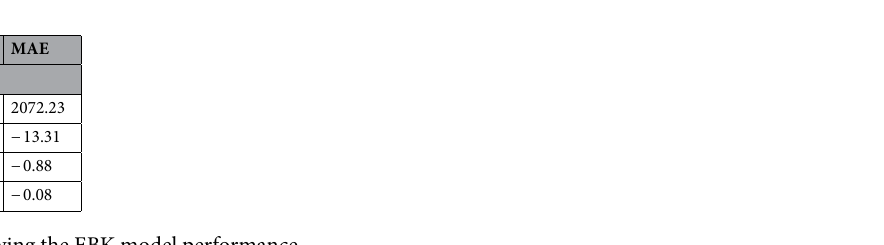
Table 2. Showing the EBK model